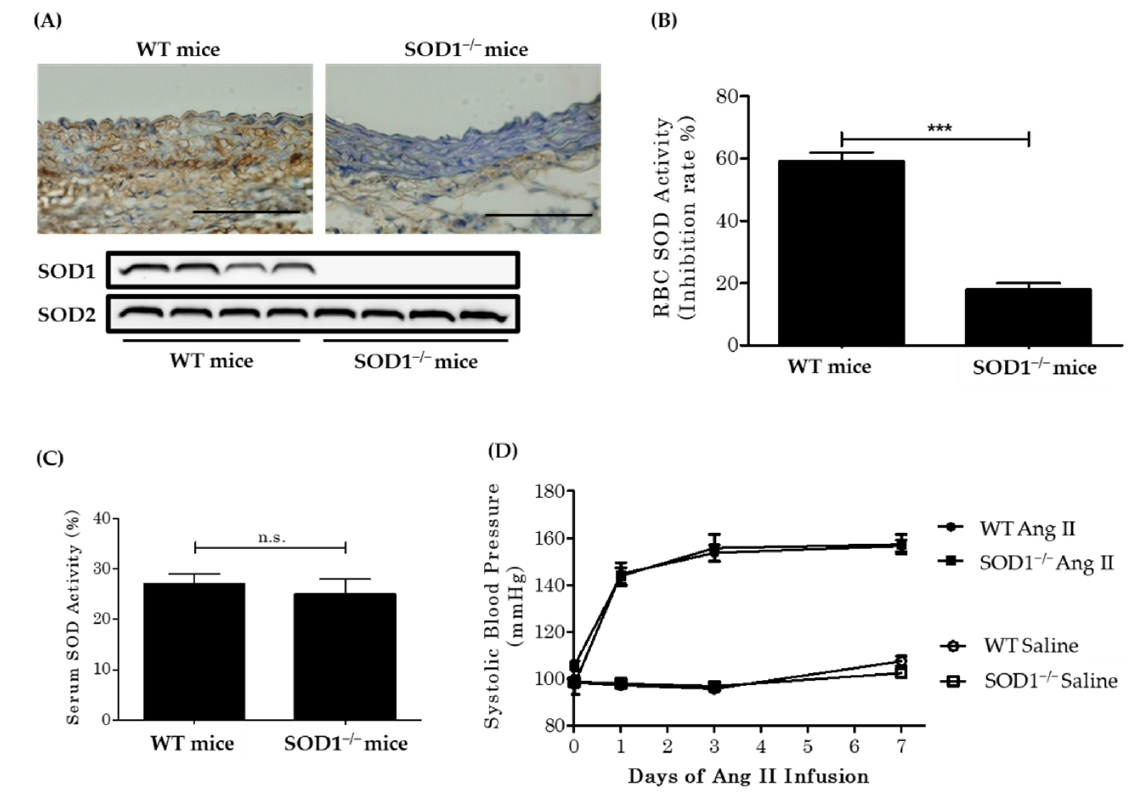
Figure 1. The efficiency of superoxide dismutase (SOD1) deletion and effect of AngII infusion on systolic blood pressure. ( A ) Immunohistochemistry (upper part) and Western blot analysis (lower part) of aortas from WT mice and SOD1 − / − mice using anti-SOD1 antibodies. (Scale bars = 100 µ m.) SOD activity in red blood cells ( B ) and serum ( C ). Red blood cells (RBCs) do not have mitochondria so SOD activity would be that of cytosol SOD (SOD1). ( n = 22~26 per group. *** p < 0.001 n.s.: not significant). ( D ) Saline or AngII (3.2 mg/kg per day) was chronically infused using osmotic mini-pumps. Systolic blood pressure was measured by the tail-cuff method ( n = 12 per group). Error bars represent SEM. WT: wild type; SOD1 − / − : superoxide dismutase 1 deficient; AngII: angiotensin II.